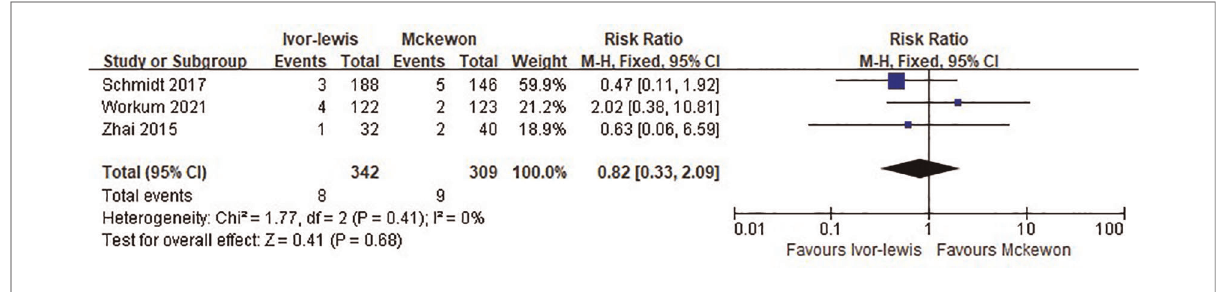
FIGURE 5 Forest plots of the 90-day mortality analysis in Ivor Lewis procedure vs. McKeown